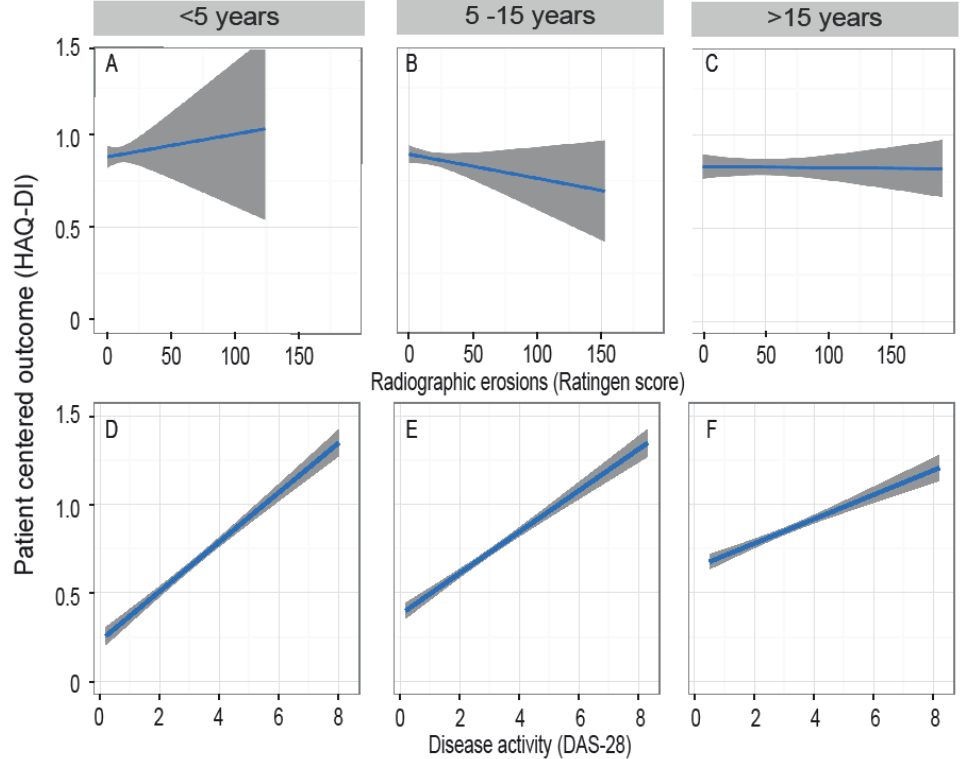
Figure 4. Correlation of HAQ-DI with radiographic destruction and disease activity stratified according to disease duration: The dependency of the HAQ-DI score from ( A – C ) Ratingen scores and ( D – F ) DAS28 scores for patients with a disease duration of <5 years ( A , D ) 5-15 years ( B , E ), and >15 years ( C , F ) are modelled by local polynomial regression fittings using a smoothness parameter of 0.1. Results are shown with 95%-CI (grey shade).